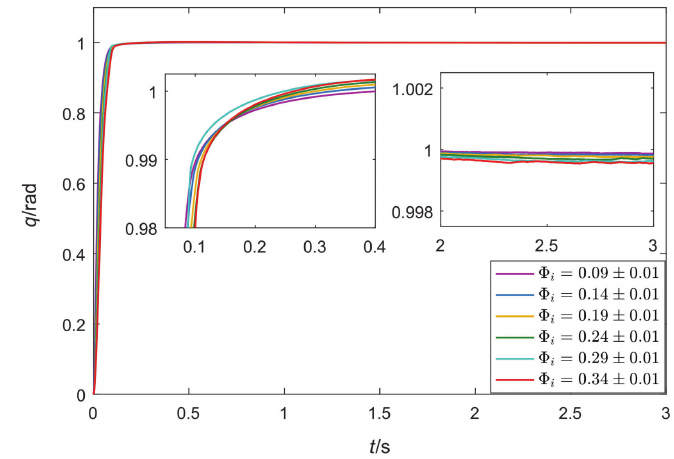
Figure 8. The parameter sensitivity analysis of Φ i